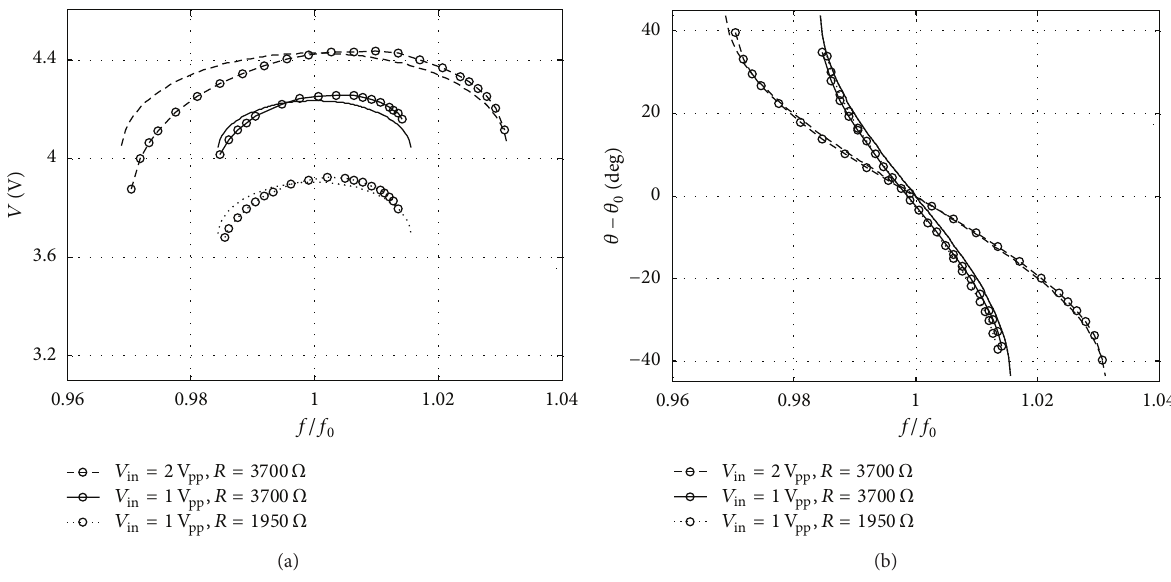
= 5 V, 𝑉 = 1 V, 𝐿 = 4.759 𝜇 H, and 𝐶 = 110 pF 0 DD